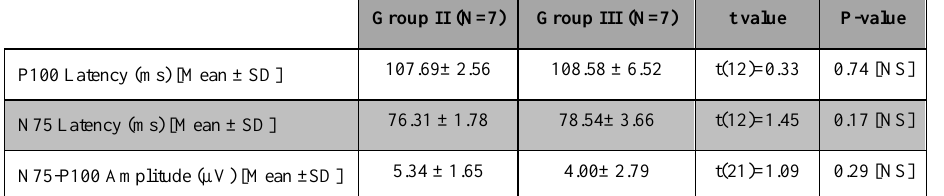
Table 13. Comparison of average VEP wave latencies and the average amplitude of both eyes between group II (having disease duration 6 to 11 years) and group III (having disease duration ≥ 11 years) diabetic patients.